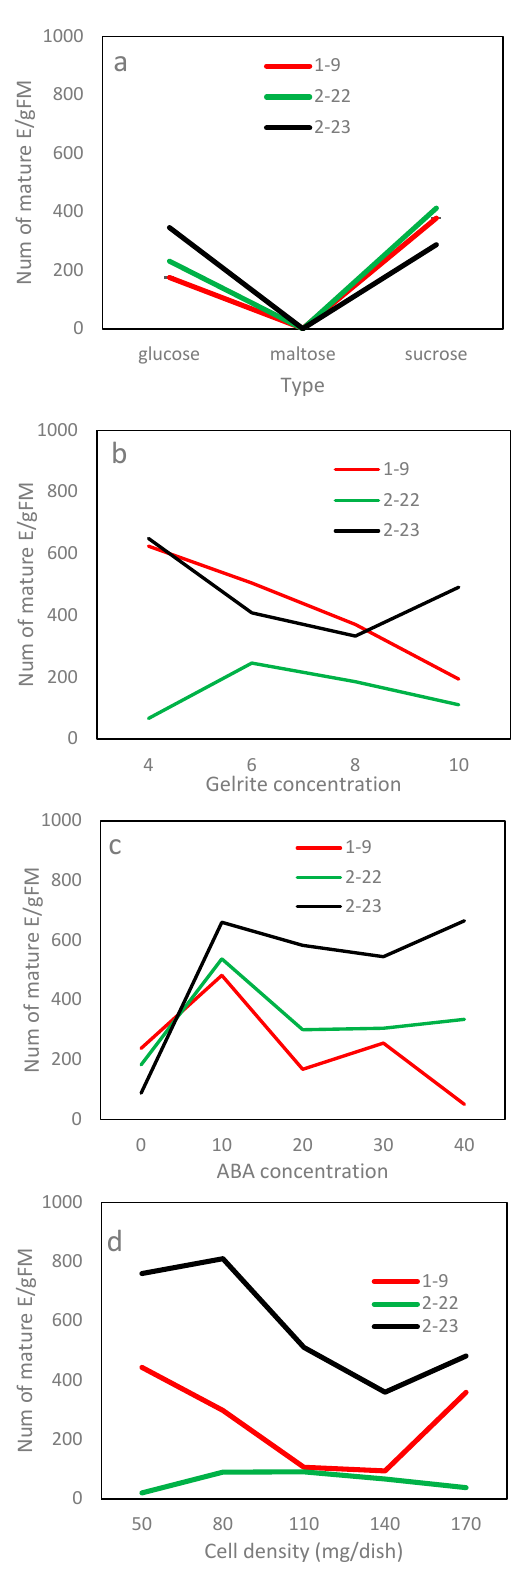
Figure 5. The interaction in maturation efficiency between the clone line and treatment by experiment: ( a ) carbohydrate type, ( b ) Gelrite, ( c ) ABA and ( d ) culture density. Note that E/gFM represents embryos obtained from per gram fresh weight tissues